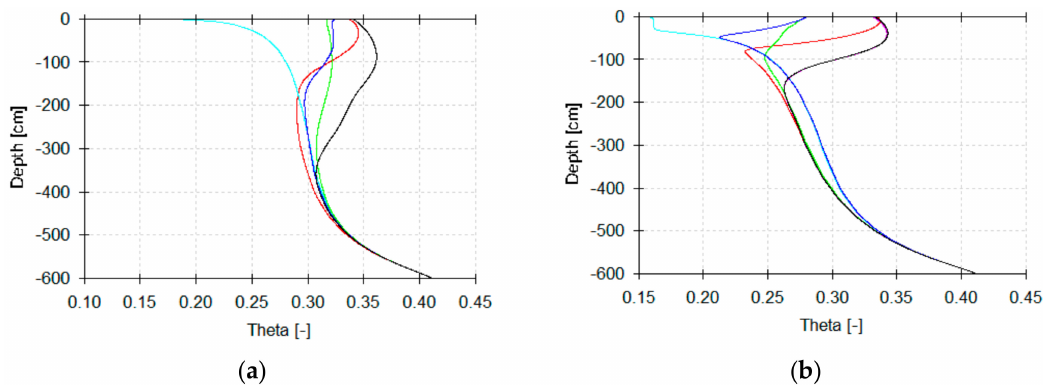
Figure 2. Volumetric water content profiles obtained from HYDRUS-1D simulations for bare clay loam ( a ) and clay loam with grass cover ( b ). Initial profiles shown in black, dark blue, green, light blue and red correspond to the end of the first, second, third and fourth year of the simulation, respectively.